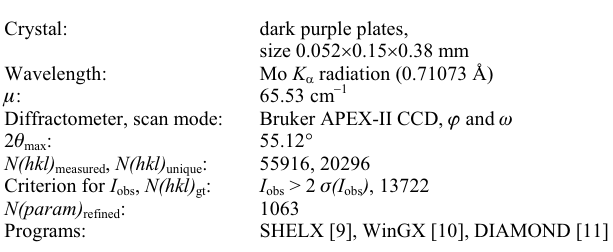
Table 1. Data collection and